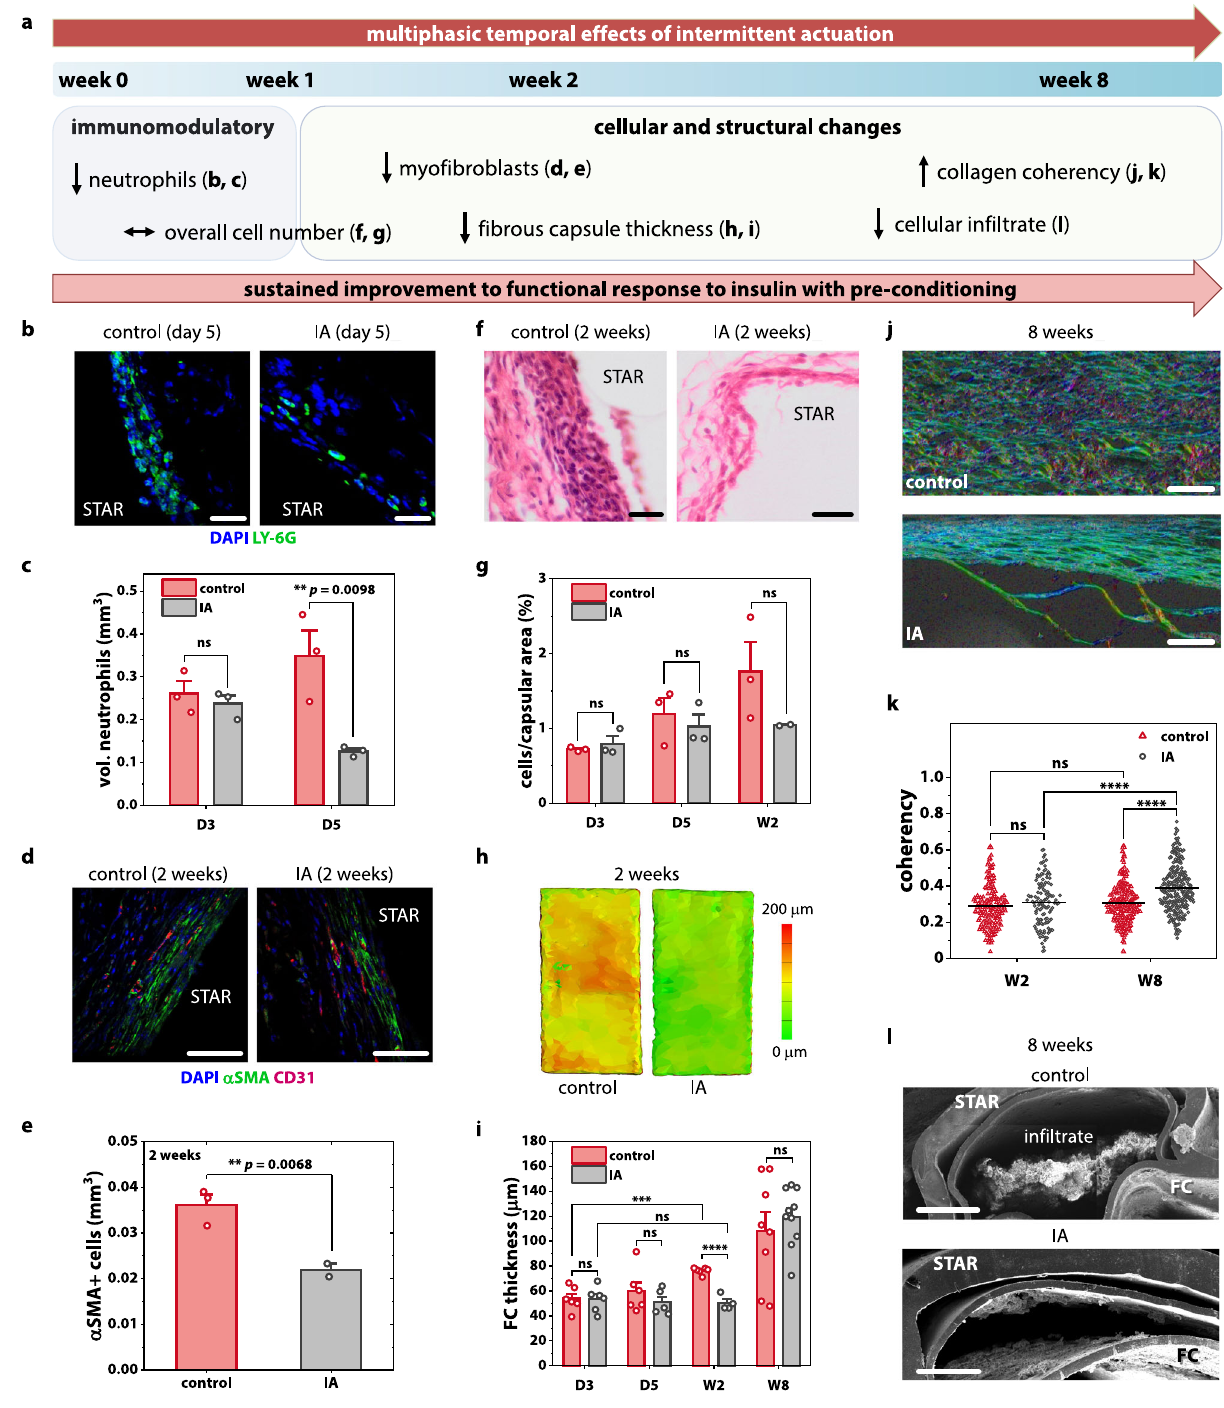
Fig.4|Multiphasictemporaleffectsofintermittentactuation(IA).a Timelineof multiphasic cellular and fi brous capsule (FC) changes induced by IA. b Representative fl uorescent images of the FC stained with Ly-6G+(green) and DAPI(blue).Scalebarsare20 µ m. c Quanti fi cationofneutrophilspresentwithinFC +/ − IAatday 3 and5. d Representative fl uorescent imagesof theFC stained with α - SMA (green) and CD31 (red). Scale bars are 50 µ m. e Quanti fi cation of myo fi bro- blastspresentwithinFC+/ − IAat2weeks. f Representative histologicimagesof the FC stained with haematoxylin and eosin. Scale bars are 20 µ m. g Quanti fi cation of total cells/capsular area +/ − IA at day 3, day 5, and 2 weeks. h Representative topographical reconstructions of µ CT images showing the differences in